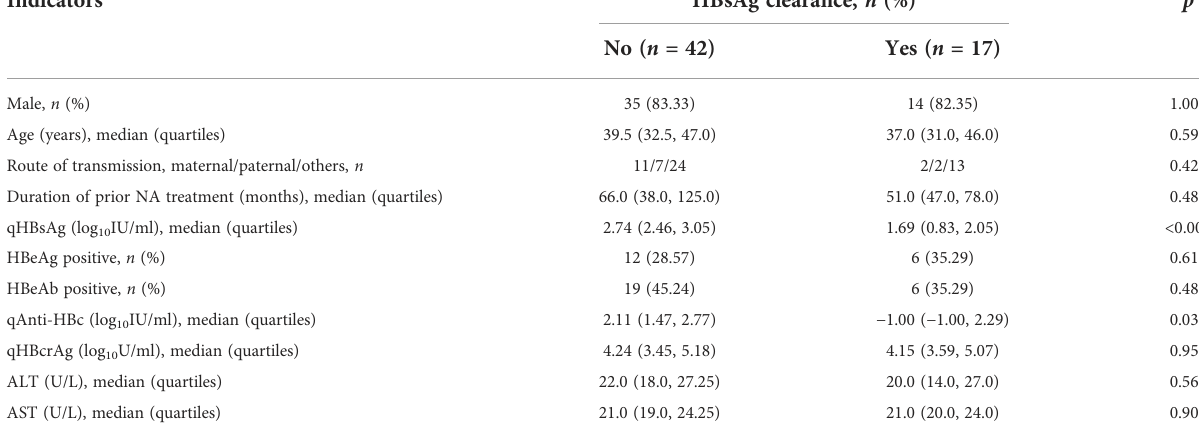
TABLE 2 Baseline characteristics of patients who achieved HBsAg clearance or not after 48-week add-on therapy. Indicators